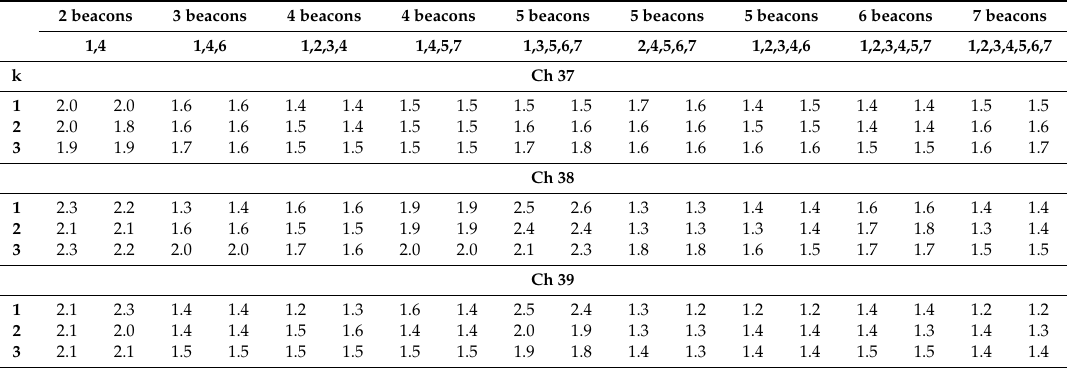
Table 15. Accuracies (in m) for Test #5, Tx code 1. For each beacon combination, the first and second data columns refer to the iBeacon and Eddystone protocol respectively. The first row shows the total number of beacons and the second shows the labels of the beacons used (see Figure 7b). The three advertising channels are referred to as Ch 37, etc., and the number of neighbors in the WKNN algorithm, as k .